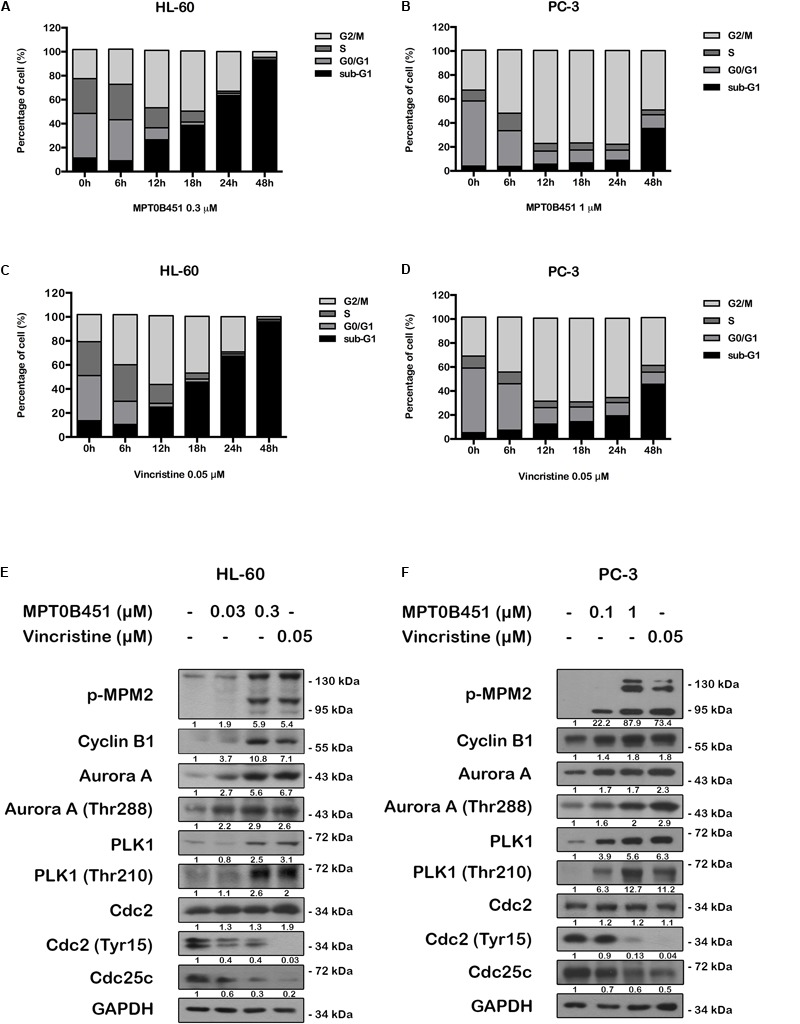
MPT0B451 induces mitotic arrest and alters G2/M proteins transition. The cell cycle was measured by flow cytometry. HL-60 (A,C) and PC-3 (B,D) cells were incubated with MPT0B451 (HL-60, 0.3 μM and PC-3, 1 μM) or vincristine (0.05 μM) for 6, 12, 18, 24, and 48 h. The quantitative data were showed in time-course. Data mean ± SD of three independent experiments. (E,F) MPT0B451 altered proteins levels that regulate the G2/M transition. Cells were treated with MPT0B451 (HL-60, 0.03, 0.3 μM and PC-3, 0.1, 1 μM) or vincristine (vin., 0.05 μM) for 12 h to evaluate G2/M phase regulatory proteins expression through western blotting. The data were repeated at least three independent experiments.